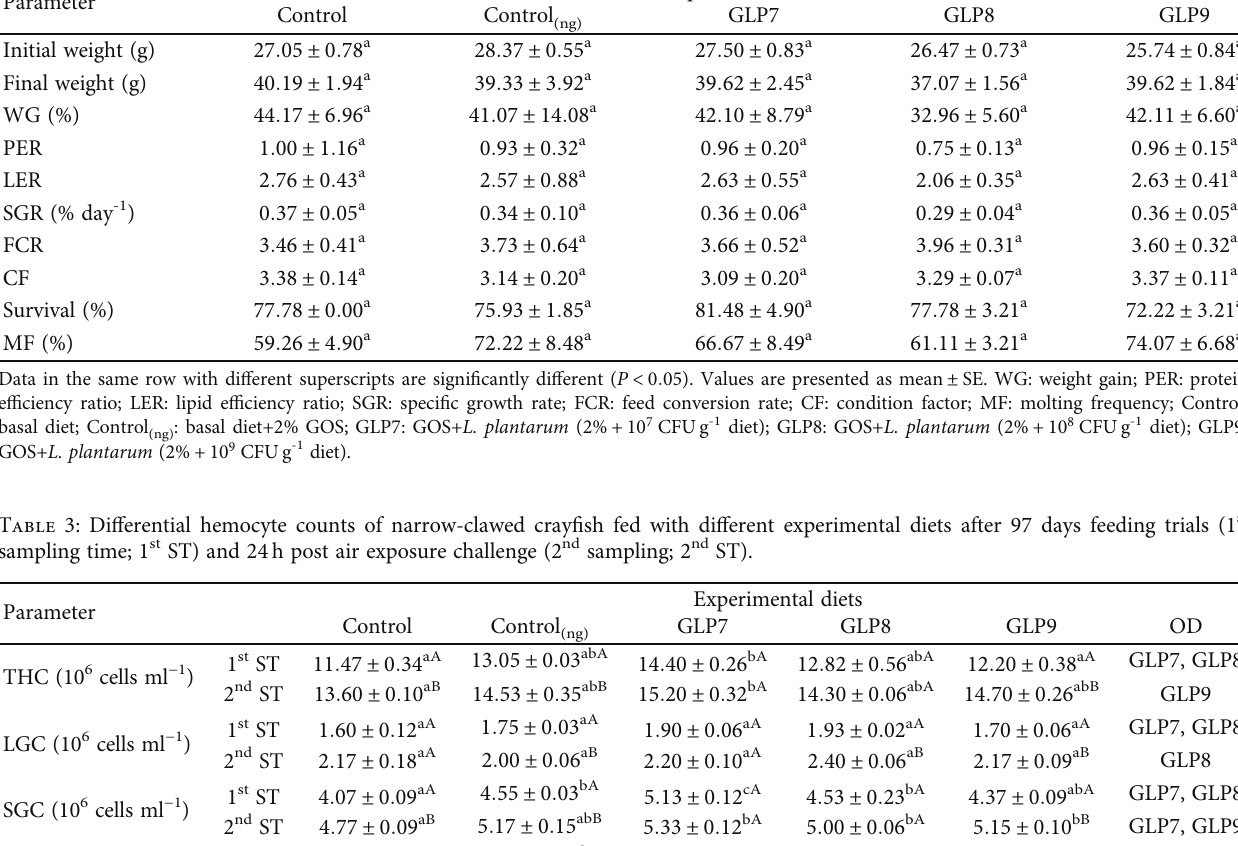
Table 2: Growth performance and survival rate of narrow-clawed cray fi sh fed with di ff erent experimental diets after 97 days. Parameter